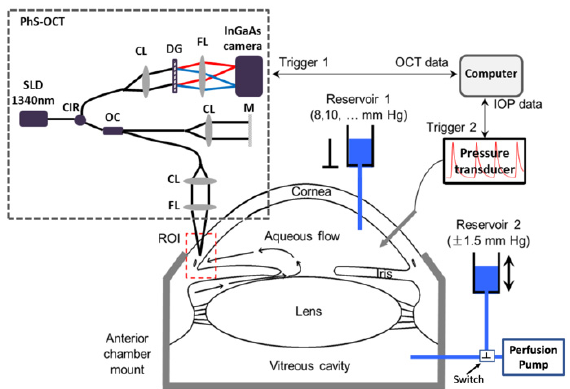
Figure 1. Schematic of the experimental setup including the PhS-OCT system (dashed box), the anterior chamber mount, the reservoir for controlling the anterior chamber pressure, the pressure transducer for recording anterior chamber pressure, the reservoir-pump perfusion system for controlling posterior chamber pressure and inducing pulse transients. CIR: circulator; OC: optical coupler; CL: collimation lens; FL: focusing lens; DG: diffraction grating; M: mirror.